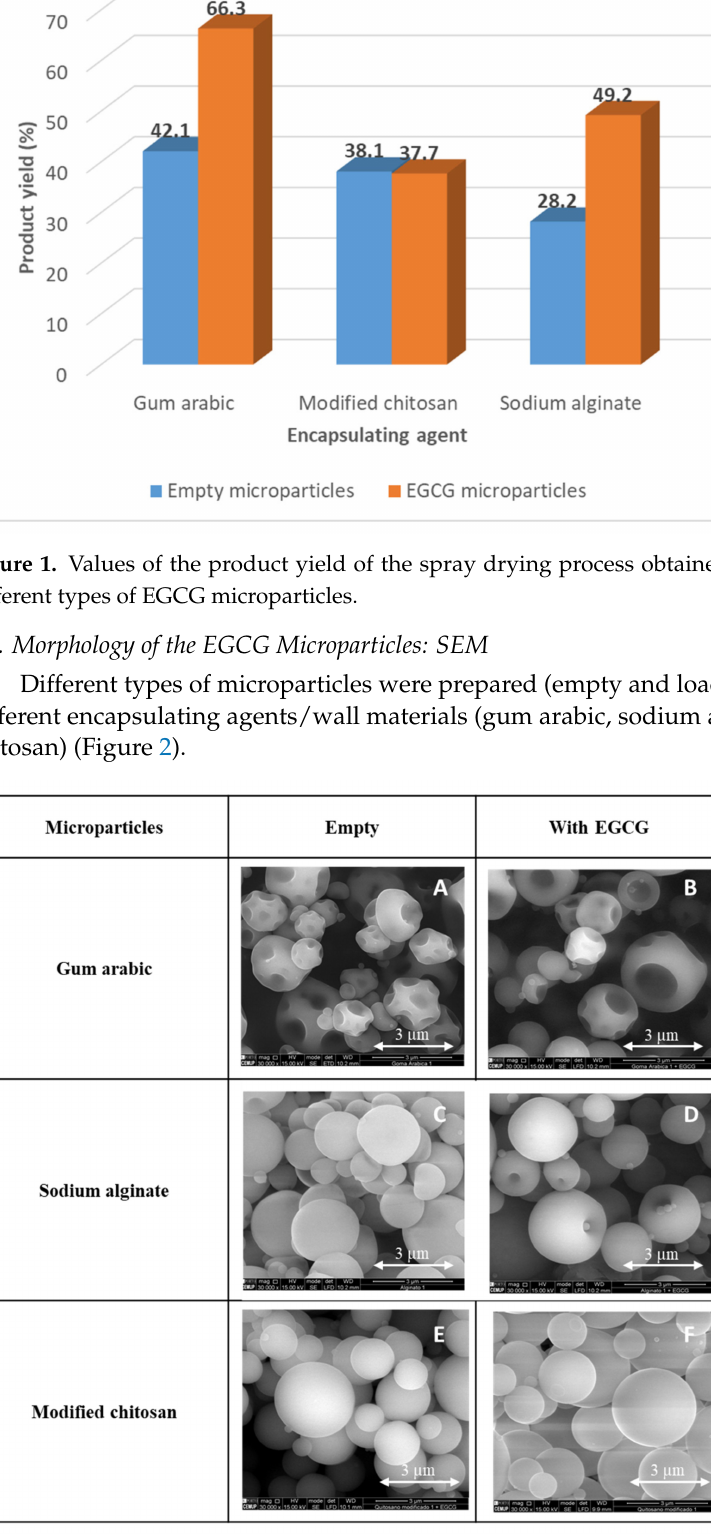
Figure 2. SEM images of the microparticles (empty and with EGCG), prepared with gum arabic ( A , B ), sodium alginate ( C , D ) and modified chitosan ( E , F ). SEM images specifications: magnification: 30,000 × , beam intensity (HV): 15.00 kV, distance between the sample and the lens (WD): ± 10